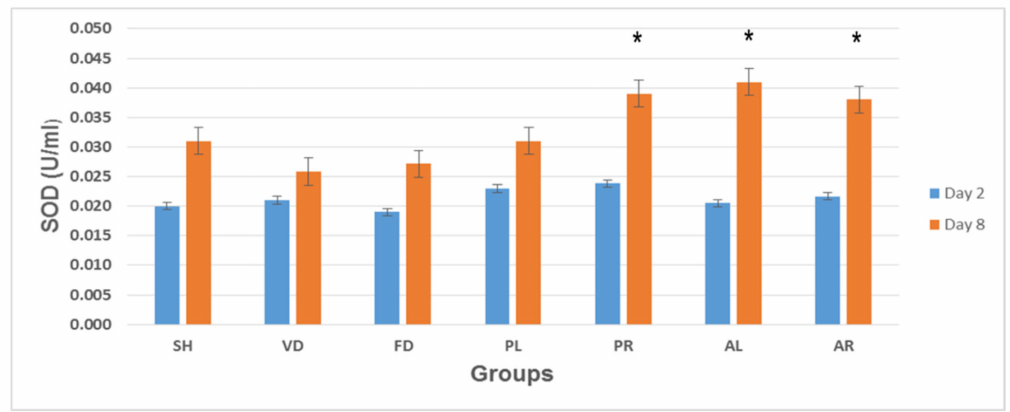
Figure 8. Superoxide dismutase (SOD) levels in skin tissue of seven rat experimental groups: SH, VD, FD, PL, PR, AL, and AR. All data are given as mean ± S.E. for six animals in each group. Statistically significant results indicated as (*) p < 0.05 versus control groups (SH, VD, and FD) on the corresponding day. SH: sham control group (without treatment); VD: treated with vehicle (Cetomacrogol ointment); FD: treated with flavine (Acriflavine 0.1%); PL: treated with 1.0% concentration of MPvp leaves extract; PR: treated with 1.0% concentration of MPvp stem roots extract; AL: treated with 2.0% concentration of MPva leaves extract; AR: treated with 2.0% concentration of MPva stem roots extract.